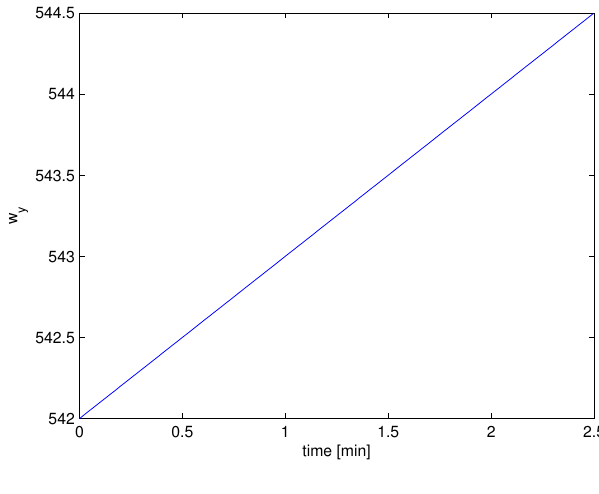
Figure 9. Reference signal minimizing J 3 .